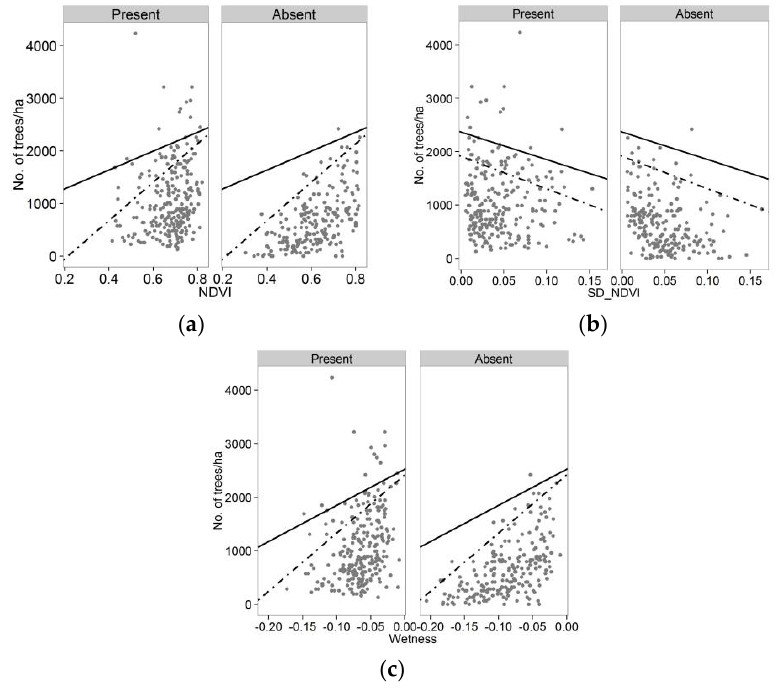
Figure 5. Results of quantile regression (tau = 0.95) for tree density (no. of trees/ha) with ( a ) NDVI; ( b ) standard deviation of NDVI; ( c ) wetness index under presence or absence of local institutions. The dashed line represents fitted values in villages without local institutions and the solid line is for villages with local institutions.